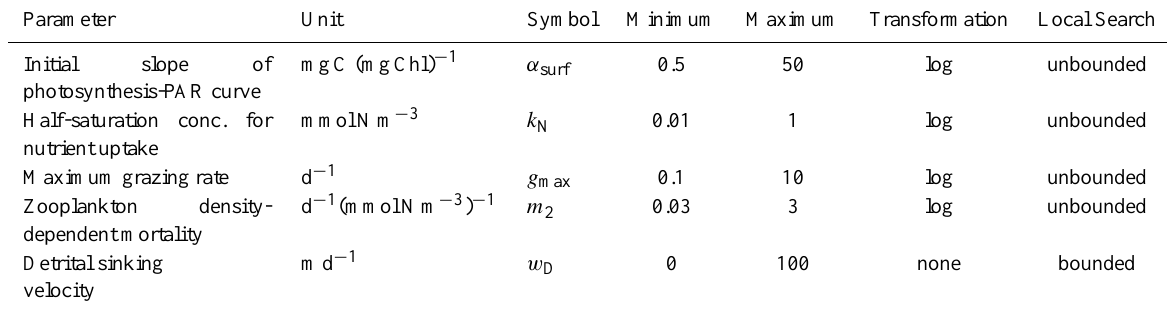
Table 1. Free parameter space. Parameter Unit Symbol Minimum Maximum Transformation Local Search Initial slope of mgC (mgChl) − 1 α surf 0.5 50 log unbounded photosynthesis-PAR curve Half-saturation conc. for mmolNm − 3 k N 0.01 1 log unbounded nutrient uptake Maximum grazing rate d − 1 g max 0.1 10 log unbounded Zooplankton density- d − 1 (mmolNm − 3 ) − 1 dependent mortality Detrital sinking md − velocity